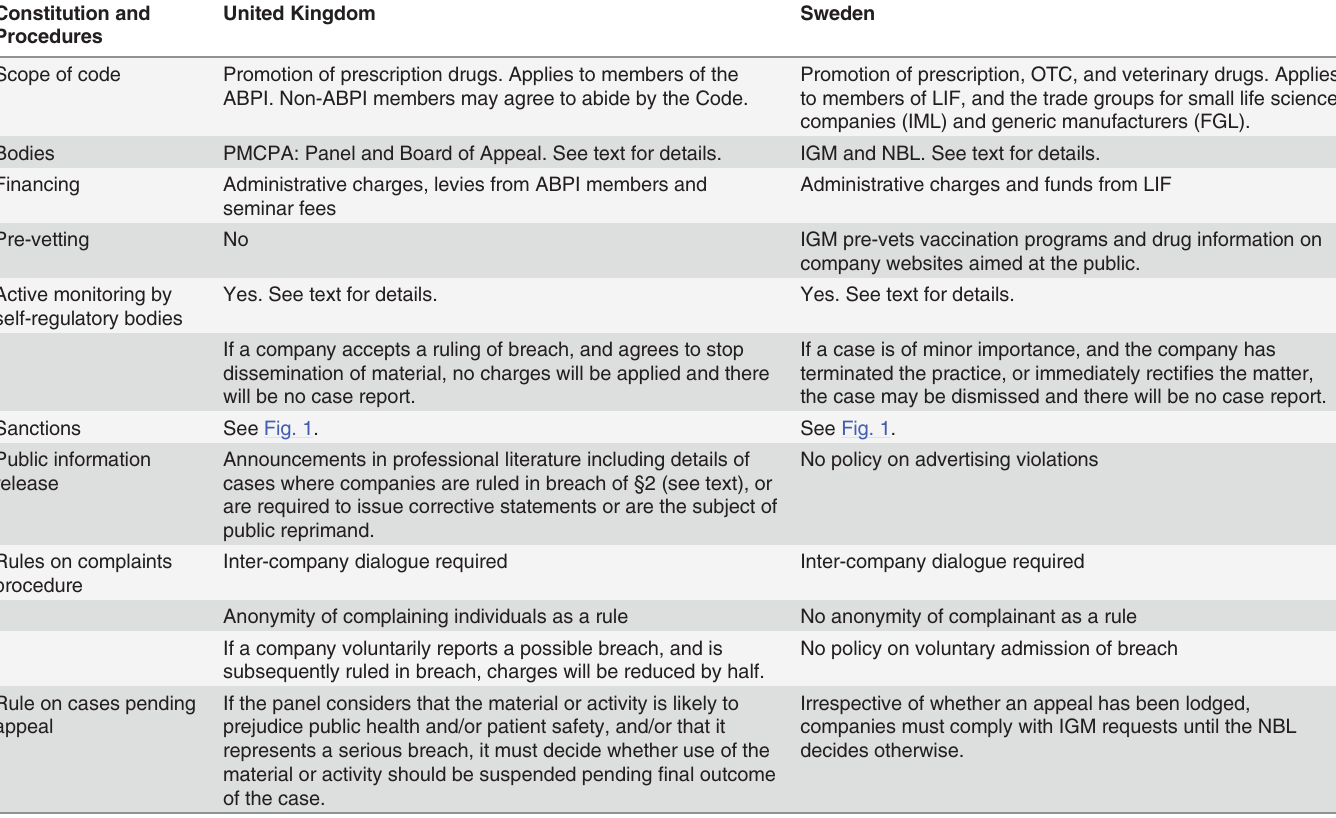
Table 2. Constitution and procedures of self-regulation in the UK and